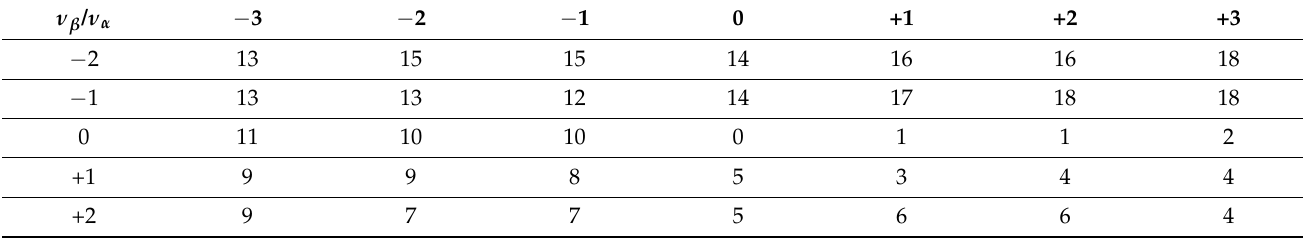
Table 1. Look-up table associated with the αβ coordinates.